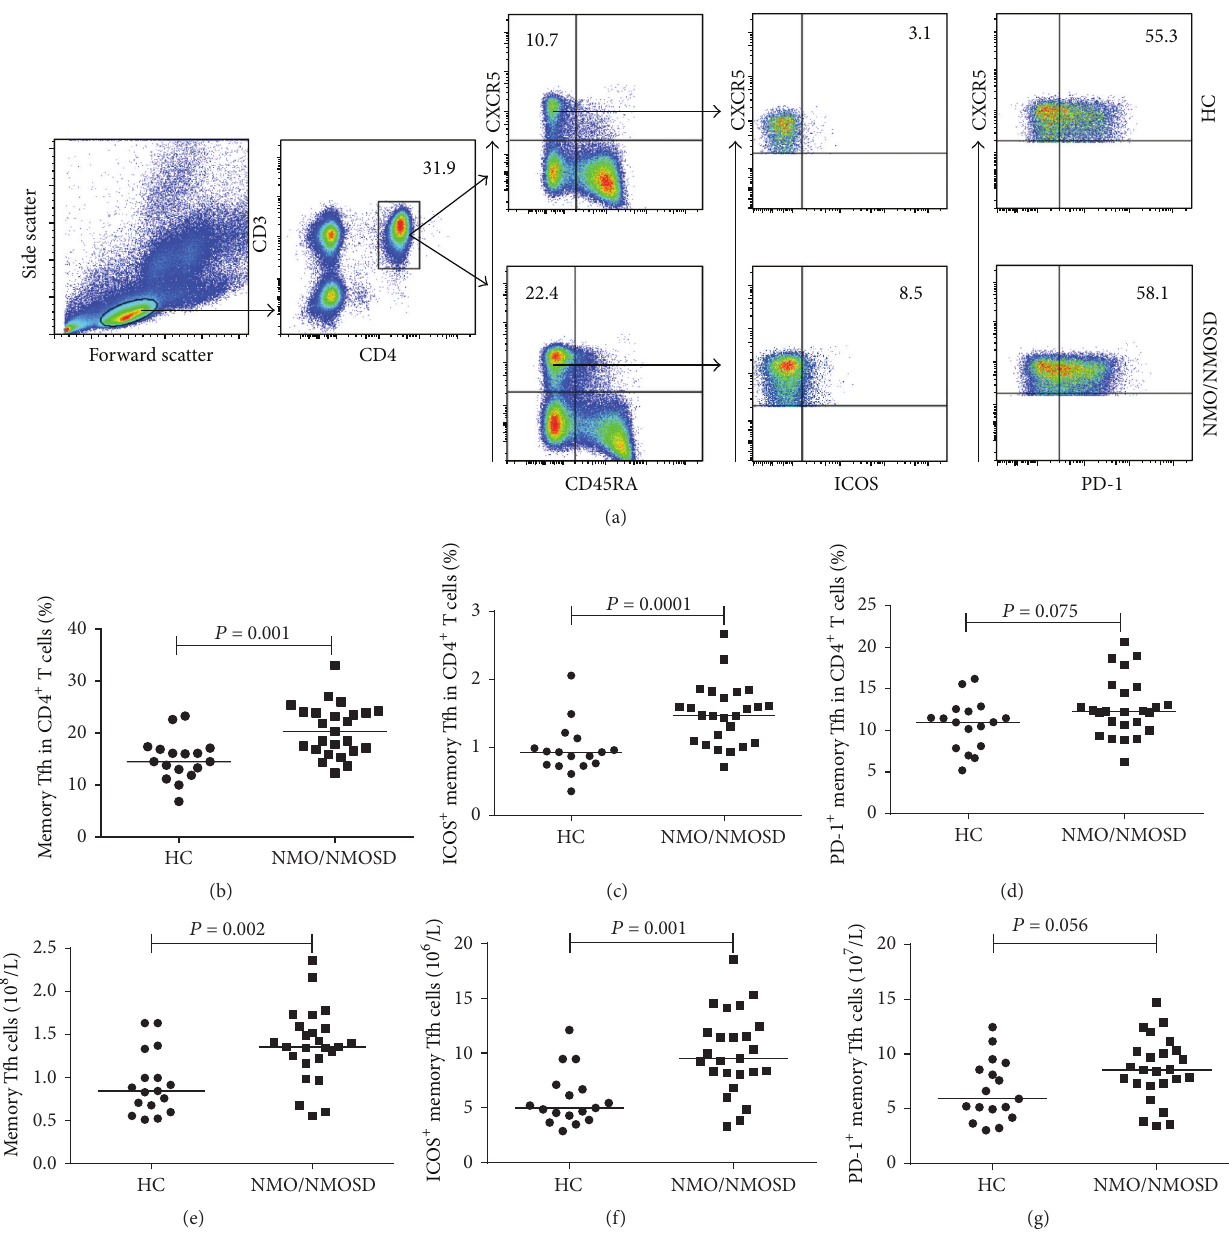
Figure 1: FACS analysis of circulating memory Tfh cells and ICOS + memory Tfh cells in individual participants. PBMCs were isolated from individual participants and stained with different fluorescent antibodies. The cells were gated on lymphocytes, CD3 + and CD4 + , and then CXCR5 + and CD45RA − cells. The percentage of CD3 + CD4 + CXCR5 + CD45RA − (memory) Tfh cells was determined. Subsequently, memory Tfh cells were gated on ICOS. We analyzed the percentages of memory Tfh and ICOS + memory Tfh cells in lymphocytes and calculated the numbers of each subtype of cells in total lymphocytes per liter. (a) Flow cytometric analysis. ((b)-(c)) The percentages of memory Tfh cells and ICOS + memory Tfh cells in HCs and untreated NMO/NMOSD patients. ((d)-(e)) The numbers of memory Tfh cells and ICOS + memory Tfh cells in HCs and untreated NMO/NMOSD patients. The horizontal lines indicate the median values for each